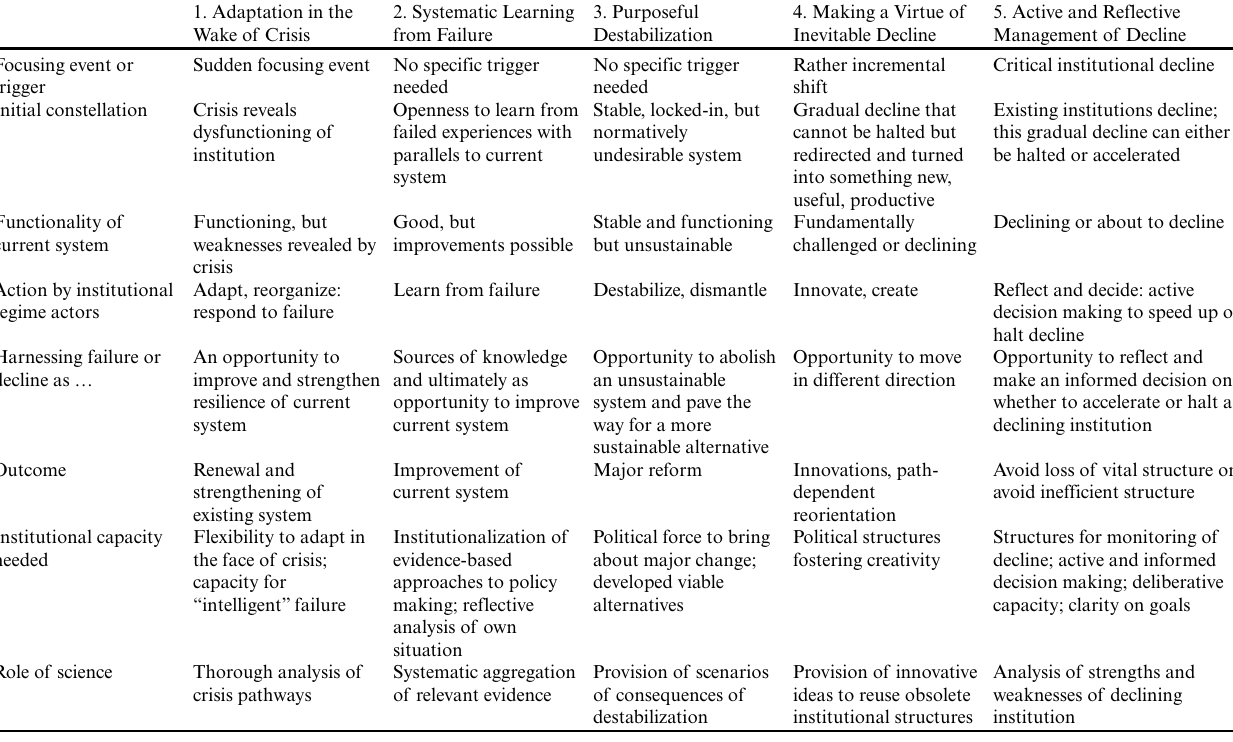
Table 2 . Archetypes of productive functions in comparison 1. Adaptation in the Wake of